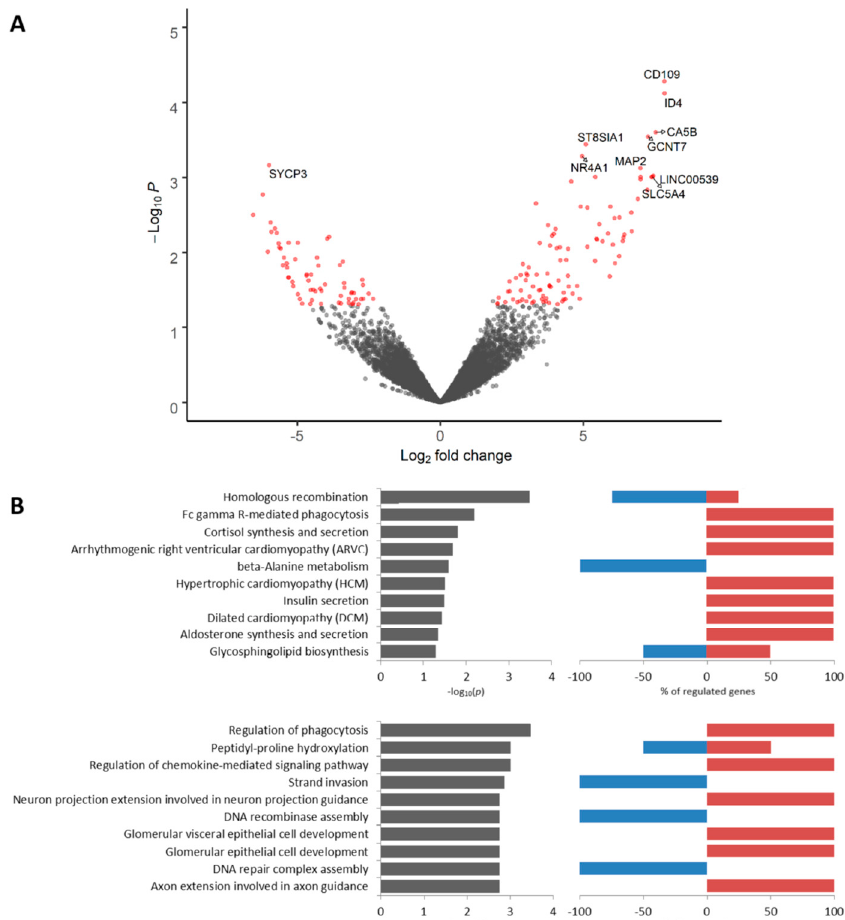
Figure 5. Differential expression analysis of EZR-negative tumor cells. Volcano plot of TOP 10 up- and downregulated genes ( A ). TOP 10 KEGG signaling pathways and GO biological processes ( B ). Up- and downregulated genes with an unadjusted p -value < 0.05 were used for functional enrichment analysis. The left panel shows –log10p of the perturbation determined from a gene set test, whereas the right panel demonstrates a percentage of genes from corresponding KEGG and GO nodes that are down- and upregulated.